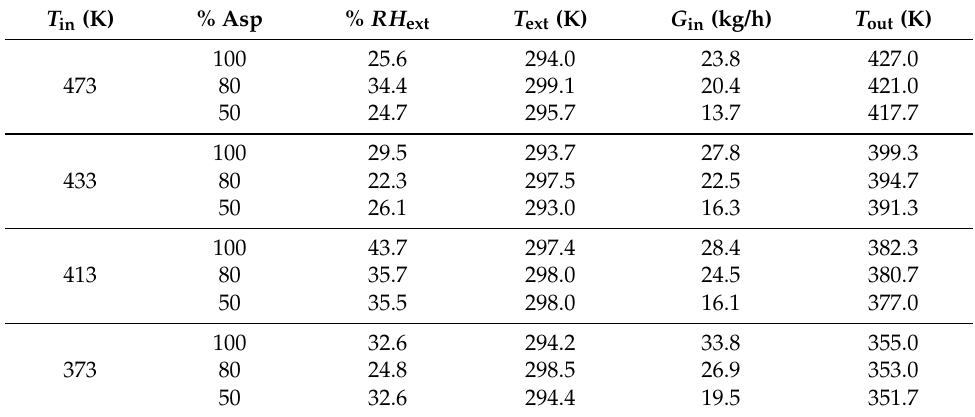
Table 1. Spray dryer results of the empty runs, performed without feed atomization. T in (K)